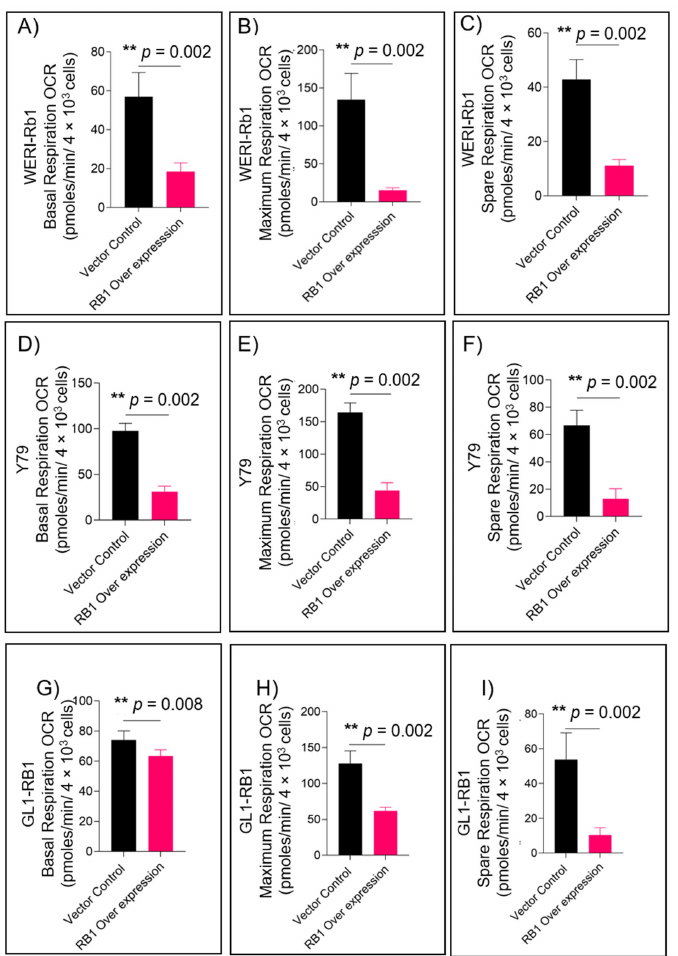
Figure 1. RB1 expression reduces mitochondrial respiration in retinoblastoma cells. Seahorse XFp mito ‐ stress test assay showing ( A ) basal respiration, ( B ) maximum respiration, and ( C ) spare respiration in WERI ‐ Rb1 cells; ( D ) basal respiration, ( E ) maximum respiration, and ( F ) spare respiration in Y79 cells; and ( G ) basal respiration, ( H ) maximum respiration, and ( I ) spare respiration in GL1 ‐ RB1 cells. Values represent the mean ± s.d. of three independent experiments. Two ‐ tailed Mann–Whitney test was used for statistical analysis. * p < 0.05, ** p < 0.01.